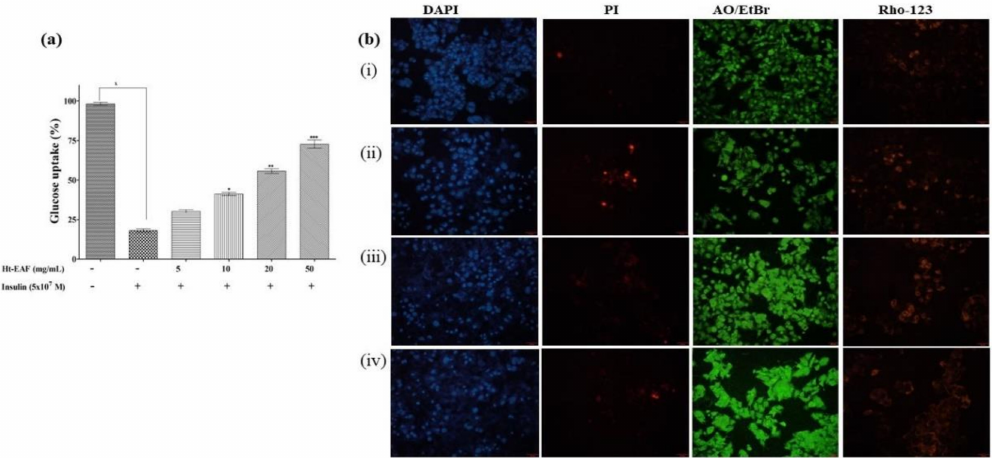
Figure 3. ( a ) Ht-EAF enhance the glucose uptake in insulin-resistant HepG2 cells. ( b ) Morphological changes of HT-EAF treated IR-HepG2 cells was screened by DAPI, PI, AO/EtBr, and rhodamine 123 and dual staining.(i) CK, (ii) 12.50 µ g/mL of Ht-EAF (iii) 200 µ g/mL of Ht-EAF (iv) 50 µ g/mL of Ht-EAF. Data were expressed as mean ± standard deviation of three independent experiments. * p < 0.001 represent the statistically significant from the untreated HepG2 cells; * p < 0.05, ** p < 0.01, and *** p < 0.001 represents the significant differences from the 5 x 10 7 M insulin-treated control